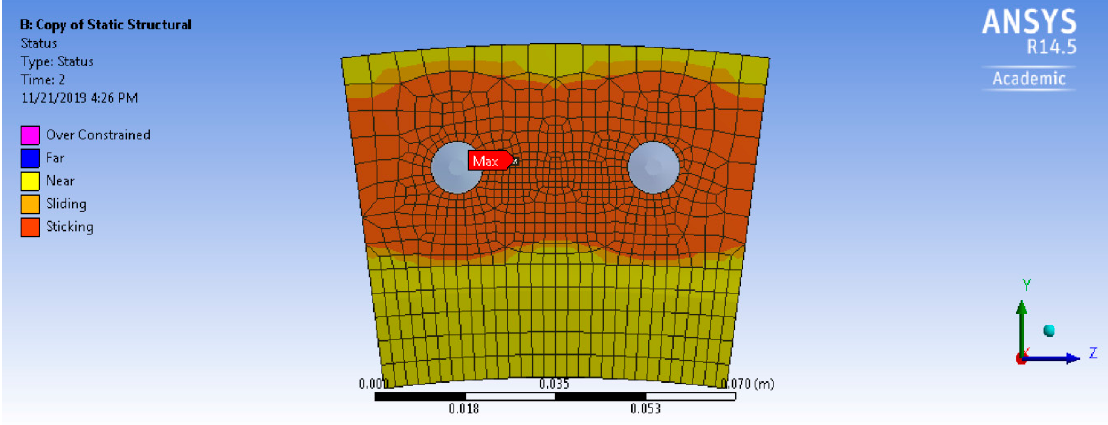
Figure 7. The flanges gliding atop and around the bolts.